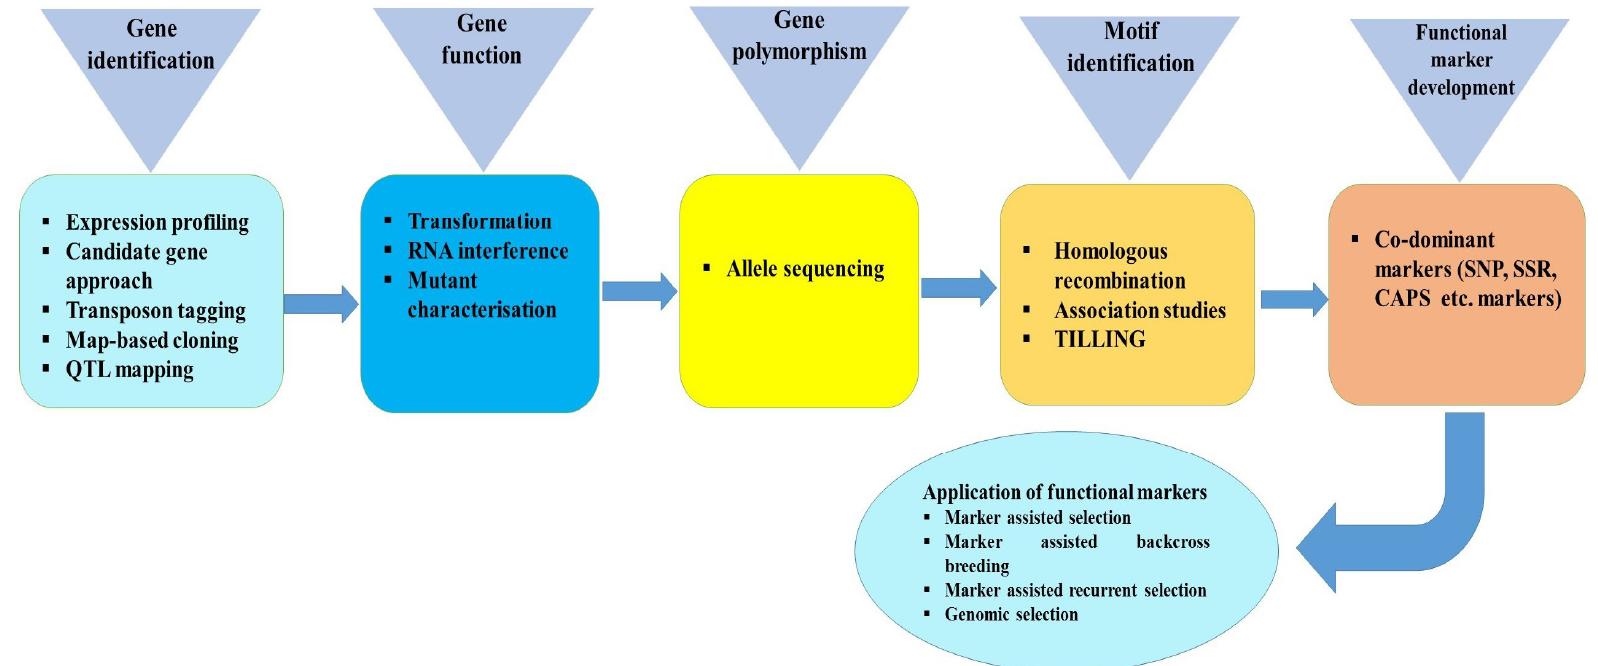
Figure 2. Di ff erent approaches involved in development of functional markers Figure 2. Different approaches involved in development of functional markers (FMs).